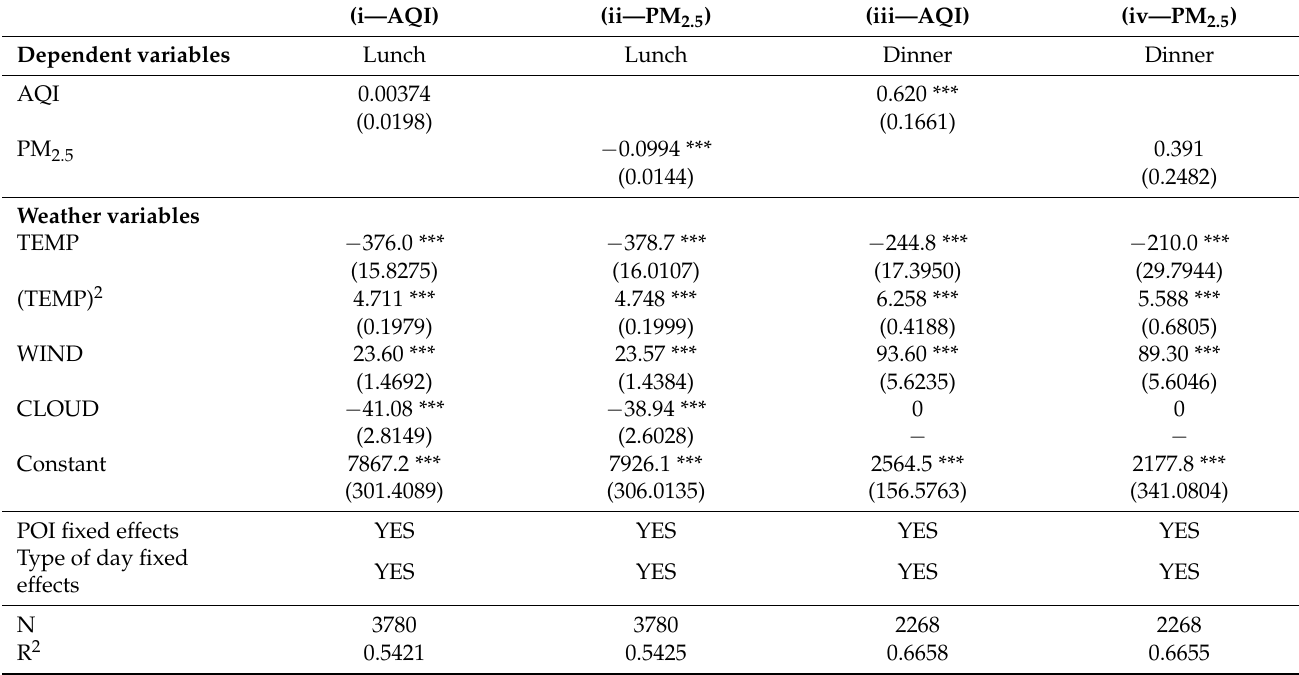
Table A13. Estimation of the effects of air pollution on the activity of eating out in restaurant